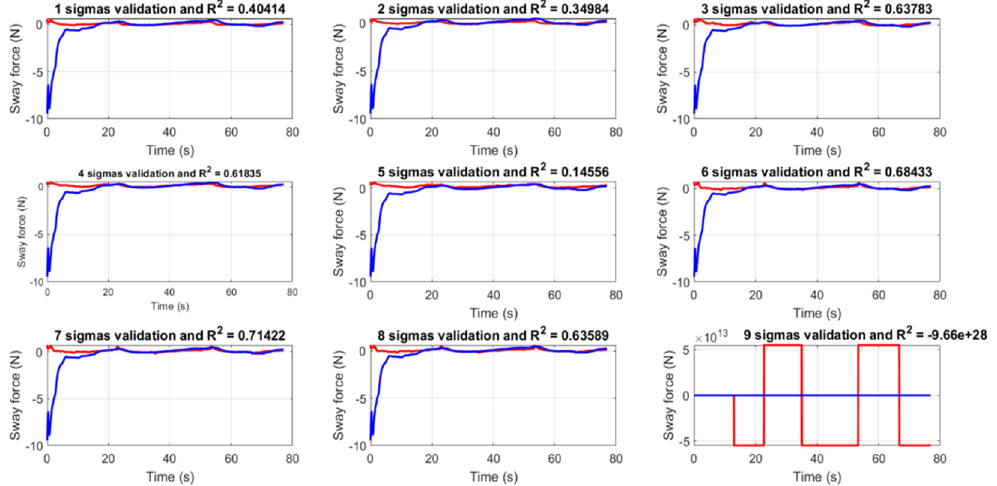
Figure 13. Results from the validation for sway motion with a 20 ◦ –20 ◦ zigzag manoeuvre tests’ data.